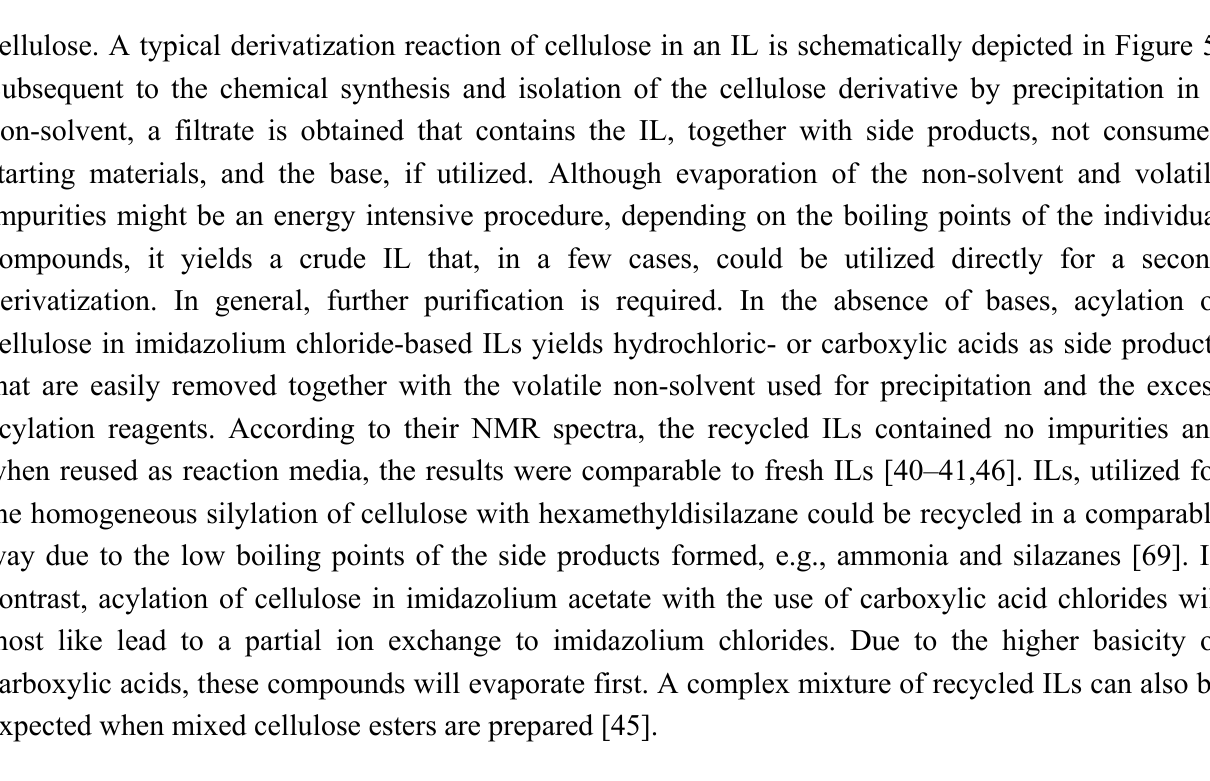
Figure 5. Scheme for the derivatization of cellulose in an ionic liquid including product isolation and solvent